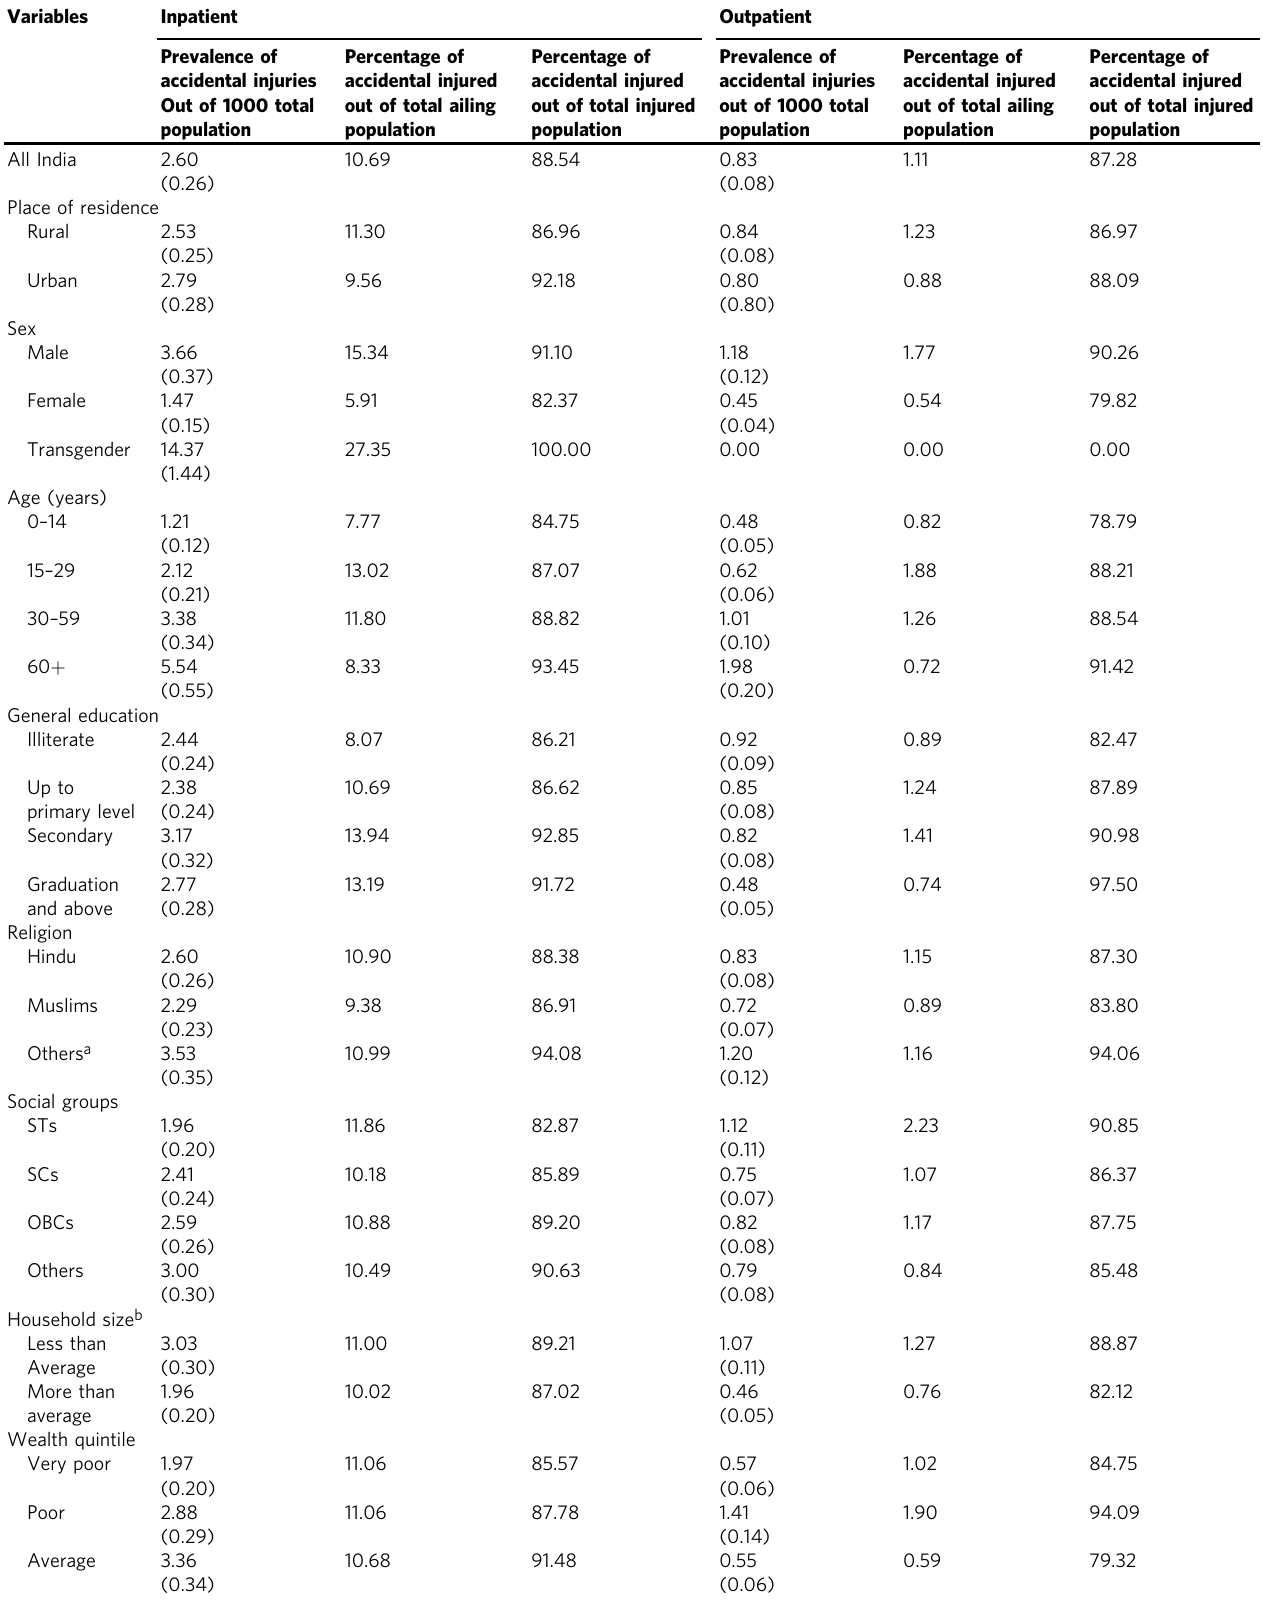
Table 3 Prevalence of accidental injuries in India (2017 –